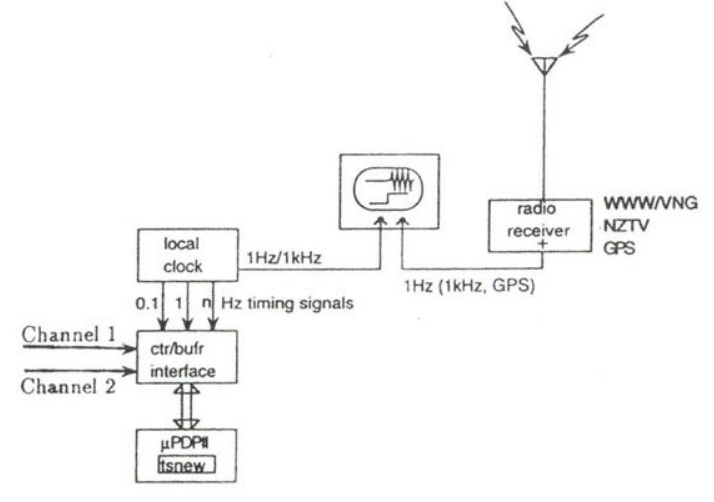
Fig. 1. The current VUW fast photometer configuration and the method used to maintain time